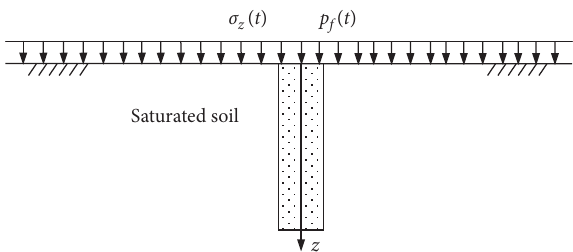
Figure 1: Investigated problem by Boer et al. [16] and Schanz and Cheng where β f � ( κ f nS r ρ f s / nS r + s ρ f κ f ) and β a � ( κ a n ( 1 − S r ) ρ a s / n ( 1 − S r ) + s ρ a κ a ) .